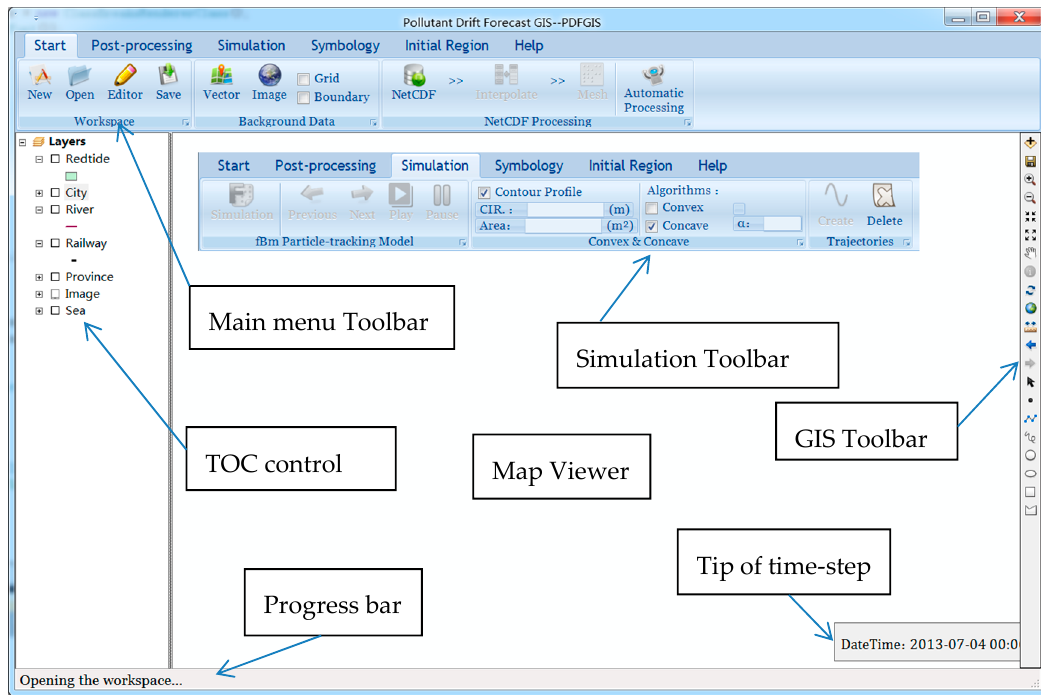
Figure 2. Main interface of the developed GIS based simulation tool.